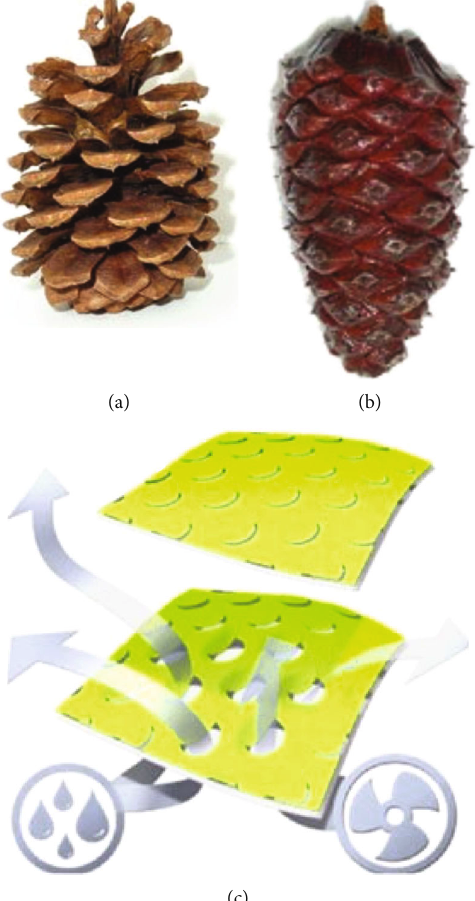
Figure 11: (a) Opening panel structure of pinecone. (b) Closing panel structure of pinecone. (c) Fabric with opening/closing panels mimicking the structure of pinecone. Table 5: Functional properties required for di ff erent sports goods. Sr.